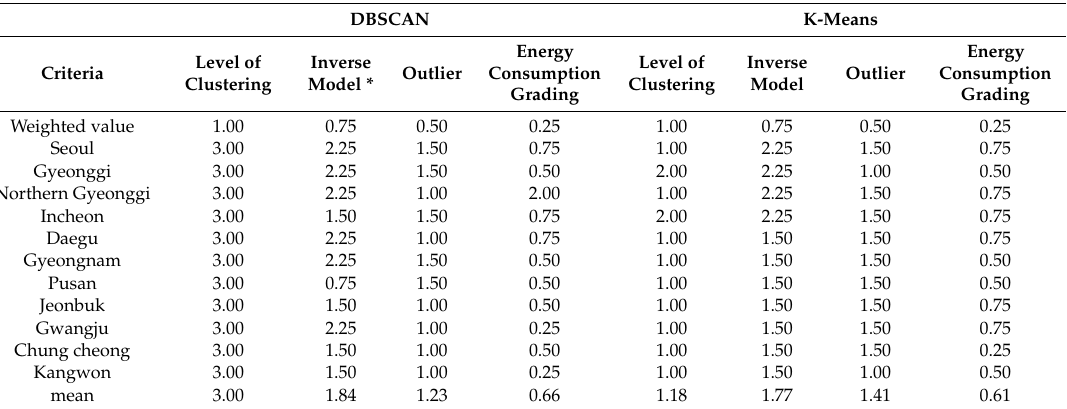
Table 5. Comparison of DBSCAN and